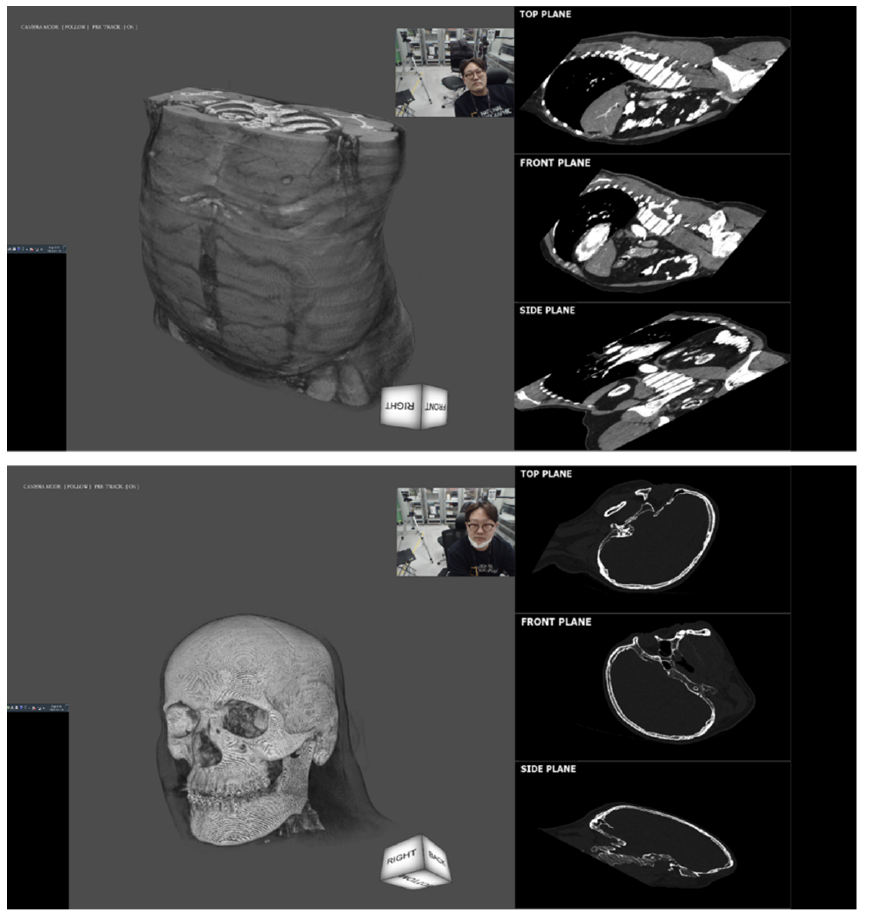
Figure 15. Examples of the proposed 3D display system being applied to other modalities; namely, abdomen CT and head CT. The inset camera images show the real-time eye tracking results for the proposed autostereoscopic 3D display.